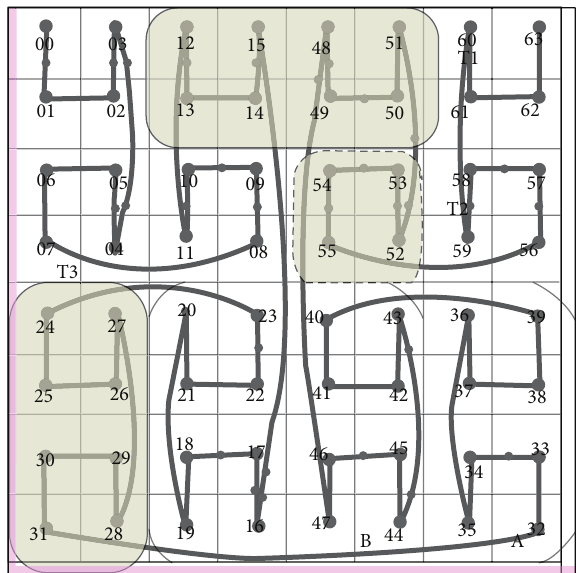
Figure 1: FPGA with some tasks already placed.